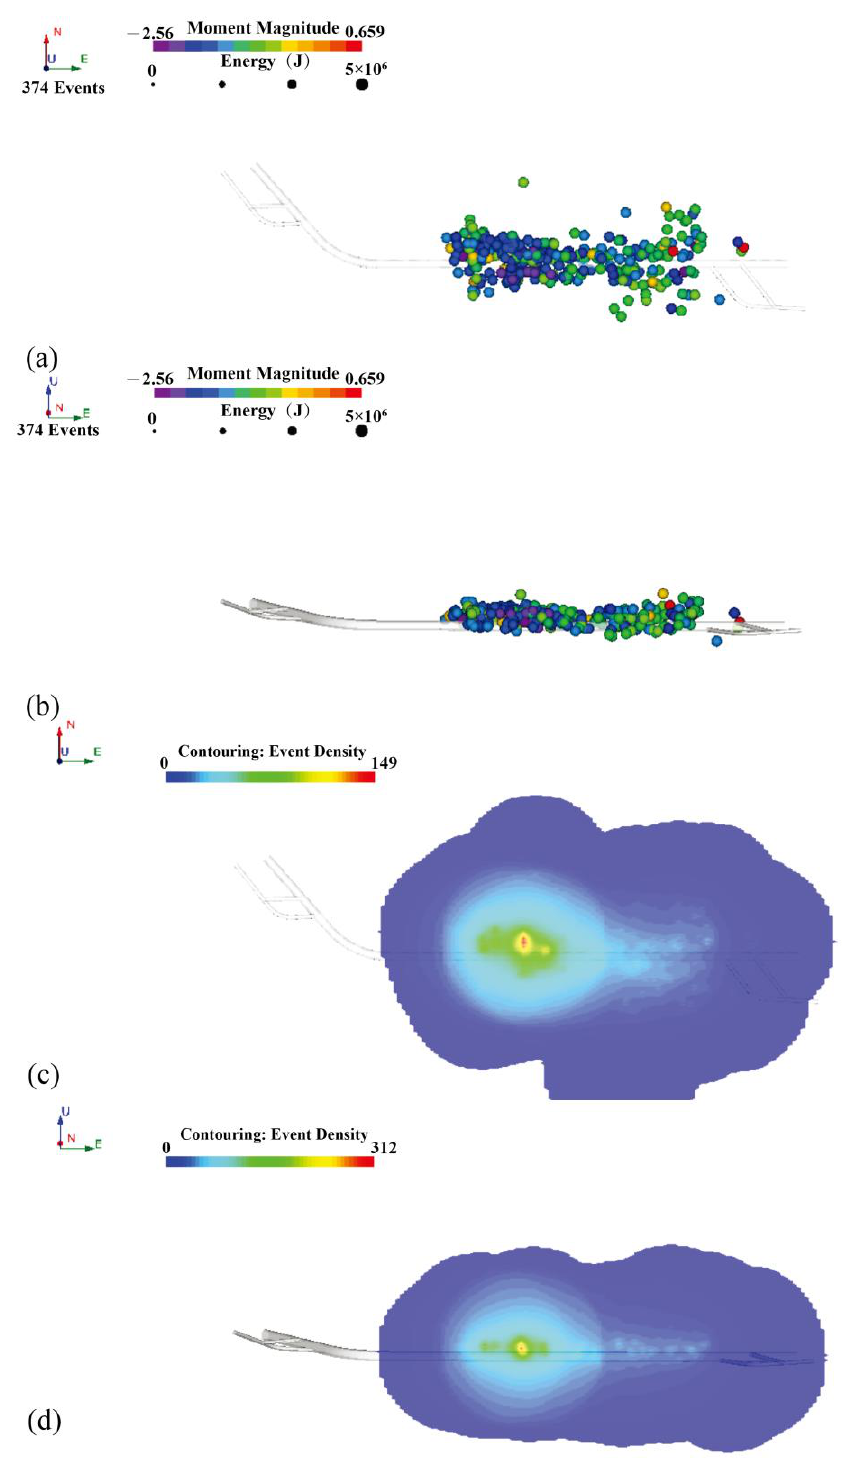
Figure 7. Spatial distributions and density cloud map of microseismic events (30 July 2020 to 18 December 2020). ( a ) Top view; ( b ) side view;( c ) top view; ( d ) side view. 4.3. Characteristic Parameter Analysis of Microseismic Activities in Special Periods 4.3.1. Es/Ep Eigenvalues